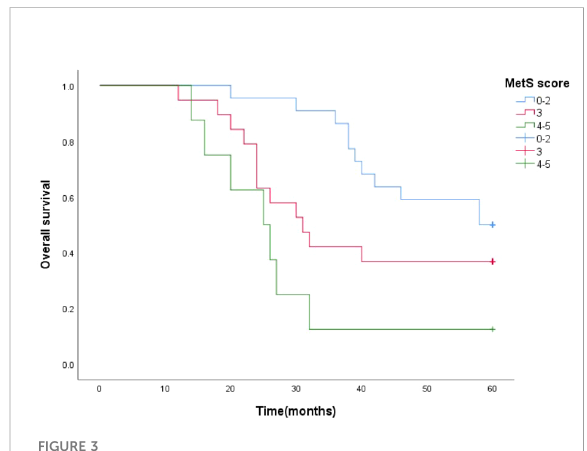
FIGURE 3 5-year survival curves for mPCA patients with different MetS